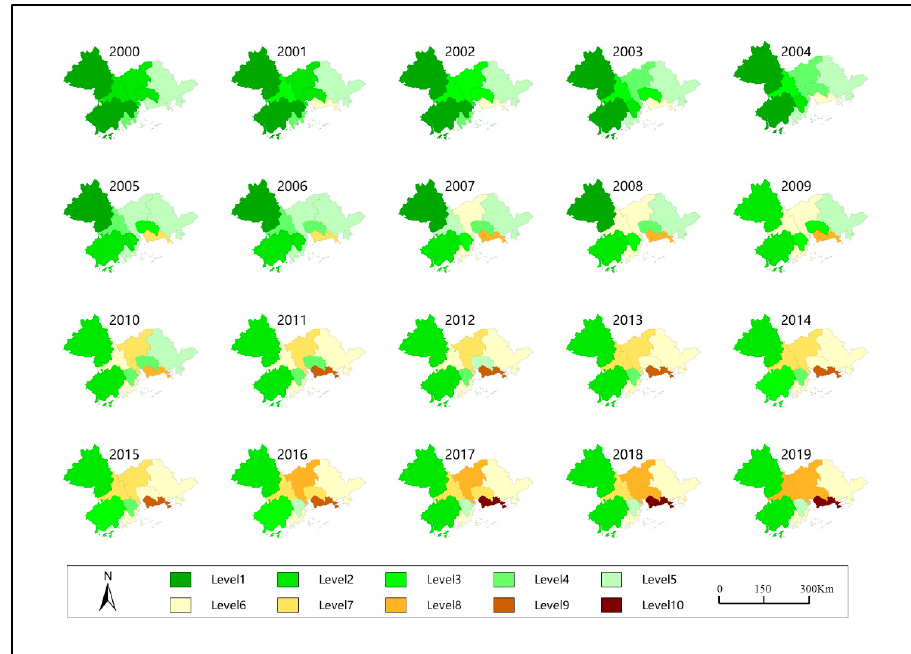
Figure 2. Level of development of the manufacturing of the cities in different year s .